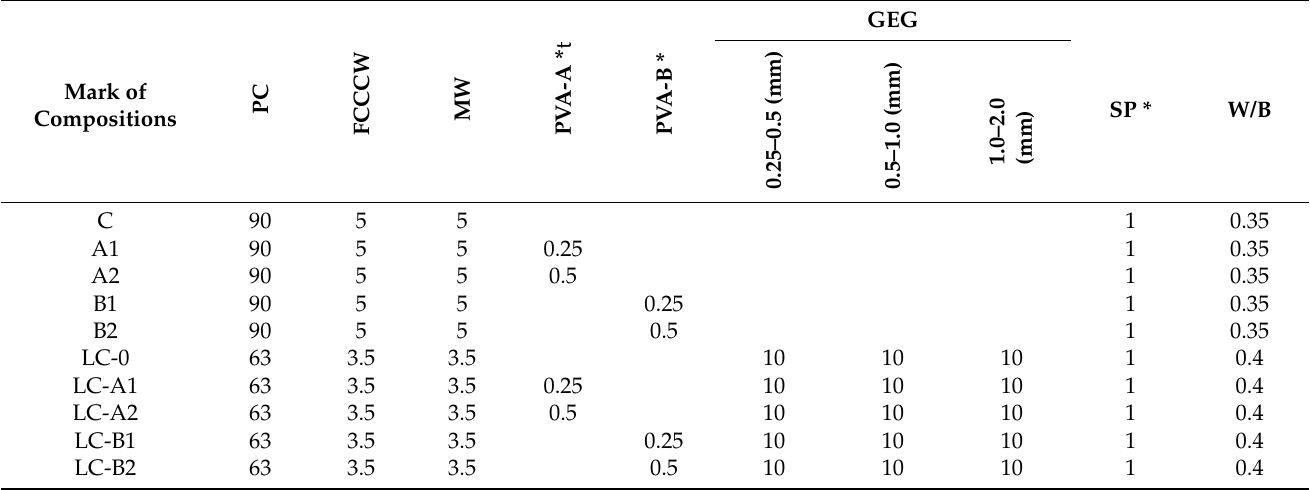
Specimens of blended cement paste and lightweight cement-based composition were mixed in a Hobart Type mixer for 2 min in dry stirring and for two more minutes after adding water. Specimens of 160 × 40 × 40 mm size were formed on the vibration table. The drying shrinkage deformation of lightweight composite was measured from the second day of curing until the 28th day. The specimens were cured for 24 h in moulds at 20 ± 2 °C and at least 90% relative humidity. On the second day they were demoulded and cured for 27 days at 20 ± 2 °C temperature and 65 ± 5% relative humidity. The density was calculated according to specimen weight (accuracy 0.01 g) and the volume was determined by dimensions (accuracy 0.01 mm).